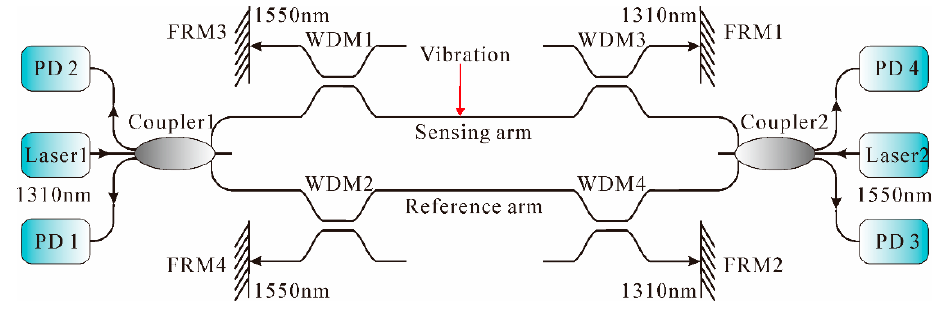
Figure 4. Schematic diagram of dual MI vibration sensors, adapted from Hong et al. [70].